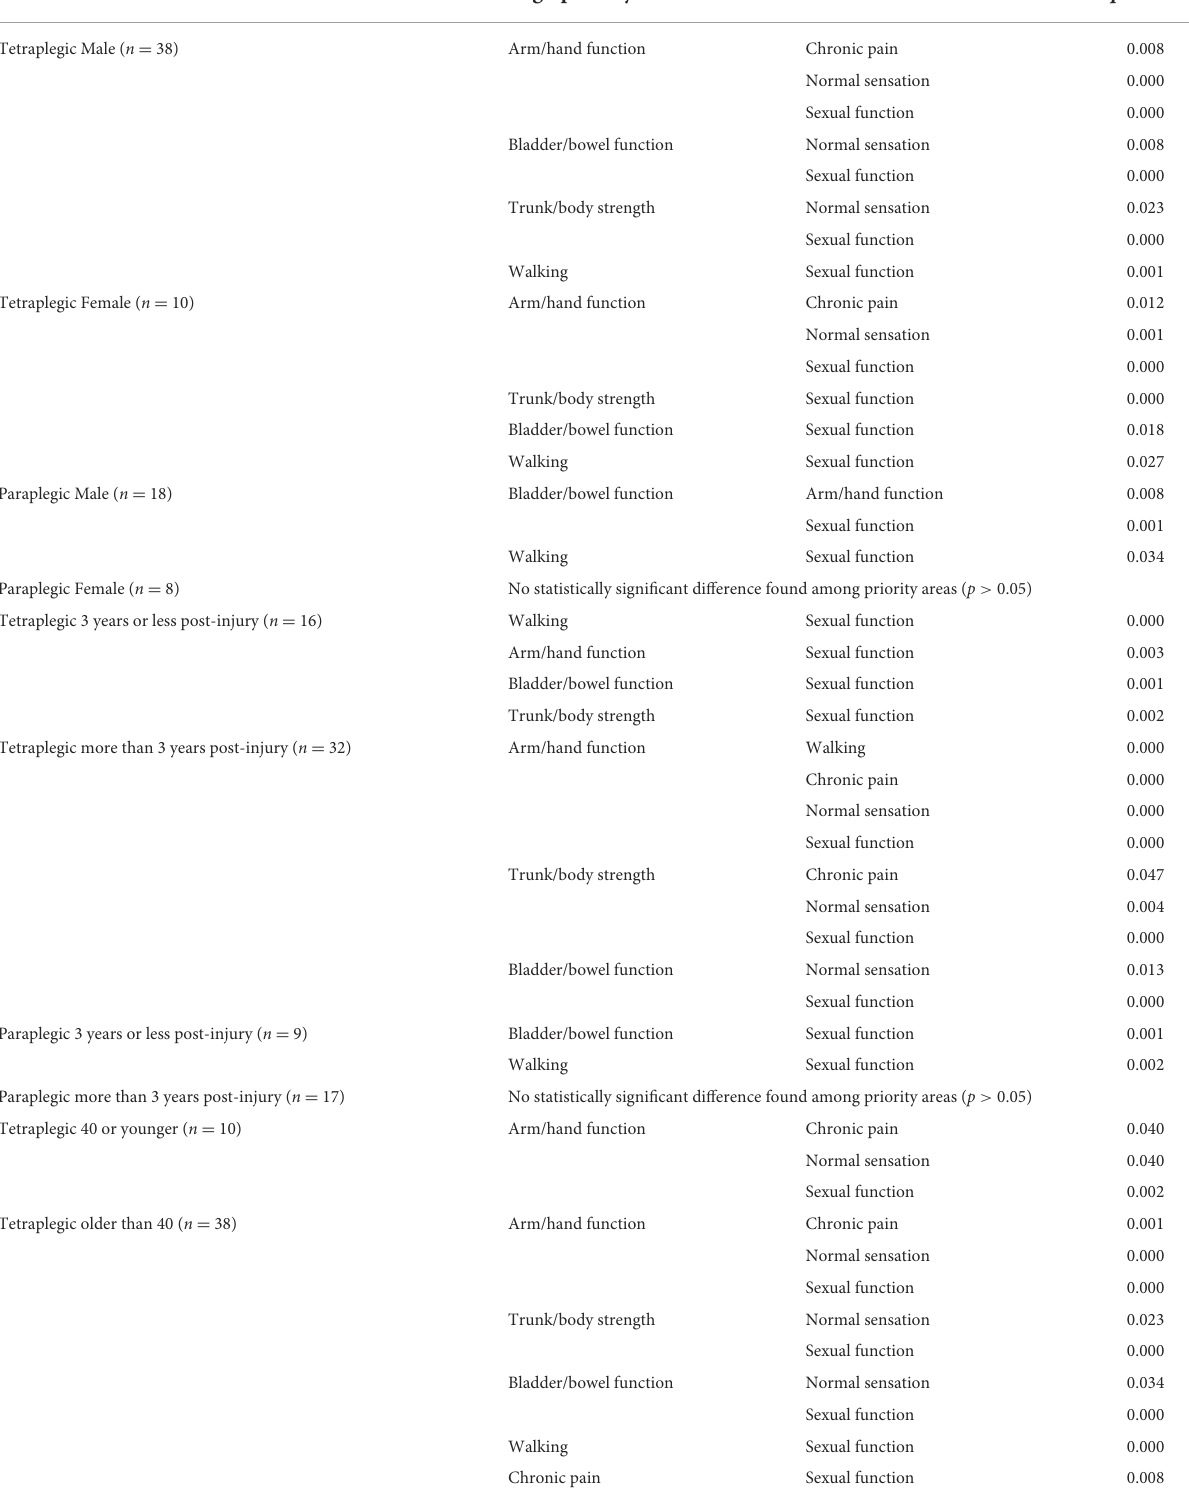
TABLE 4 Summary of statistical findings in subgroups of SCI